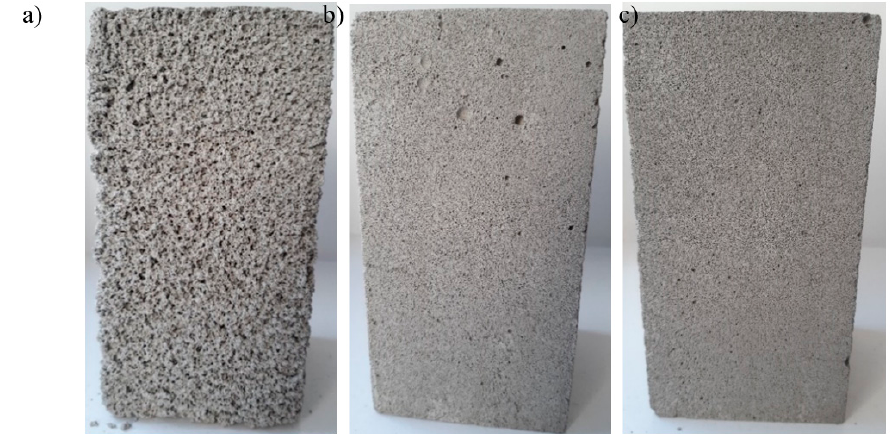
Figure 4. Ratio of difference between the density of the mixture and hardened foamed concrete to the density of hardened samples Δ γ depending on density.